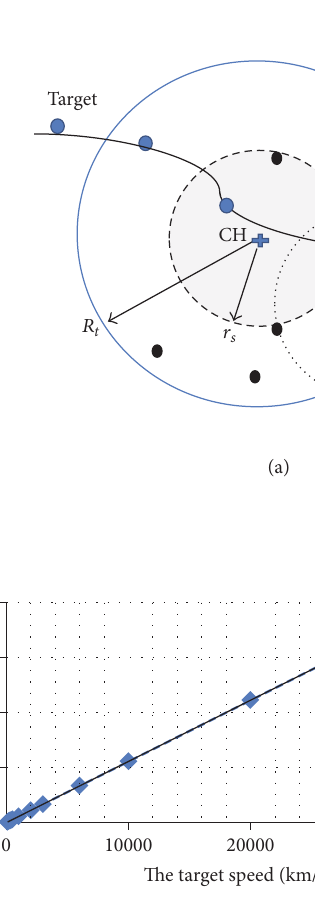
Figure 4: The traveled distance in 2